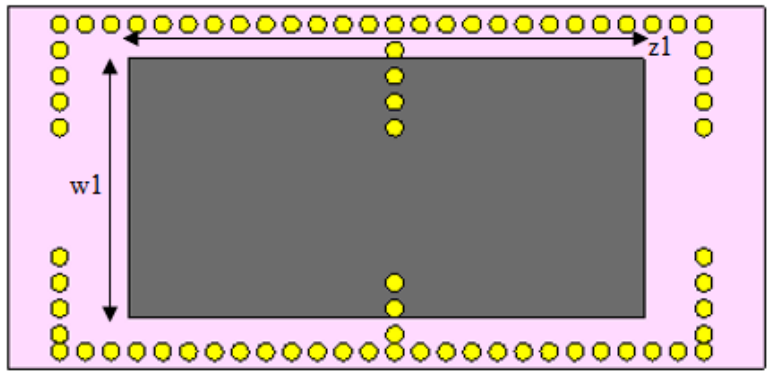
Figure 10. Length and width of